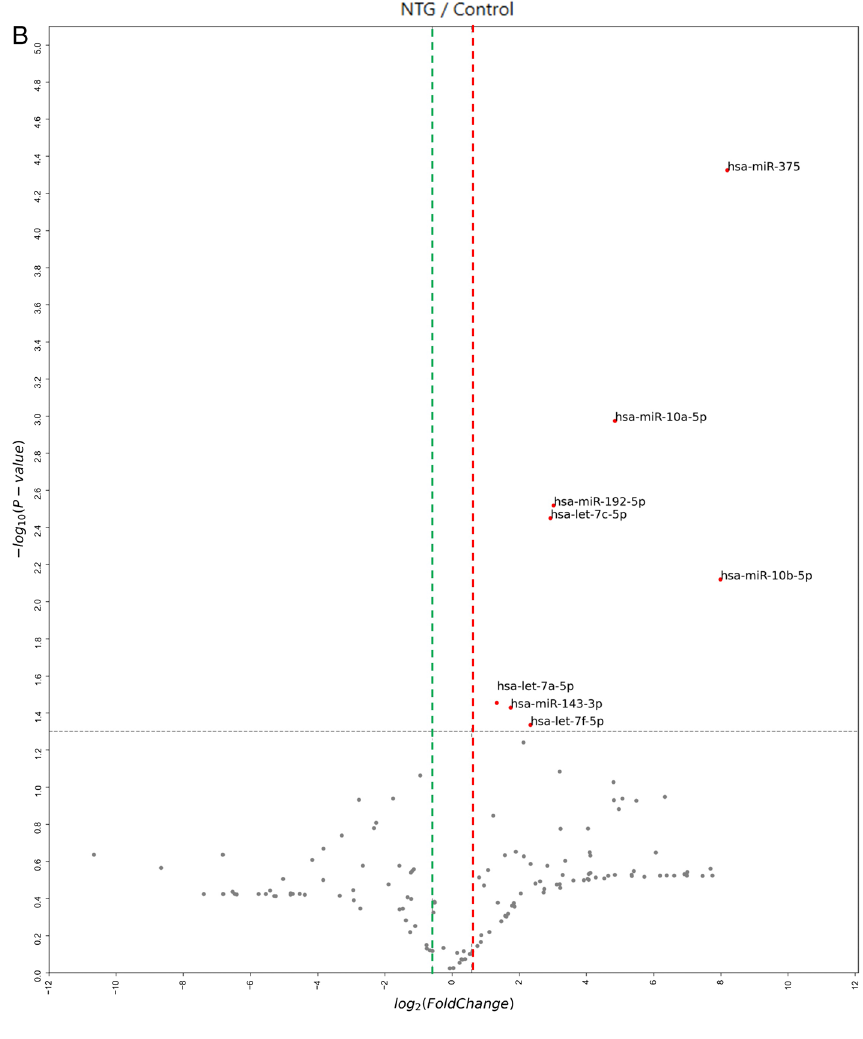
Fold change (Log2) p -value